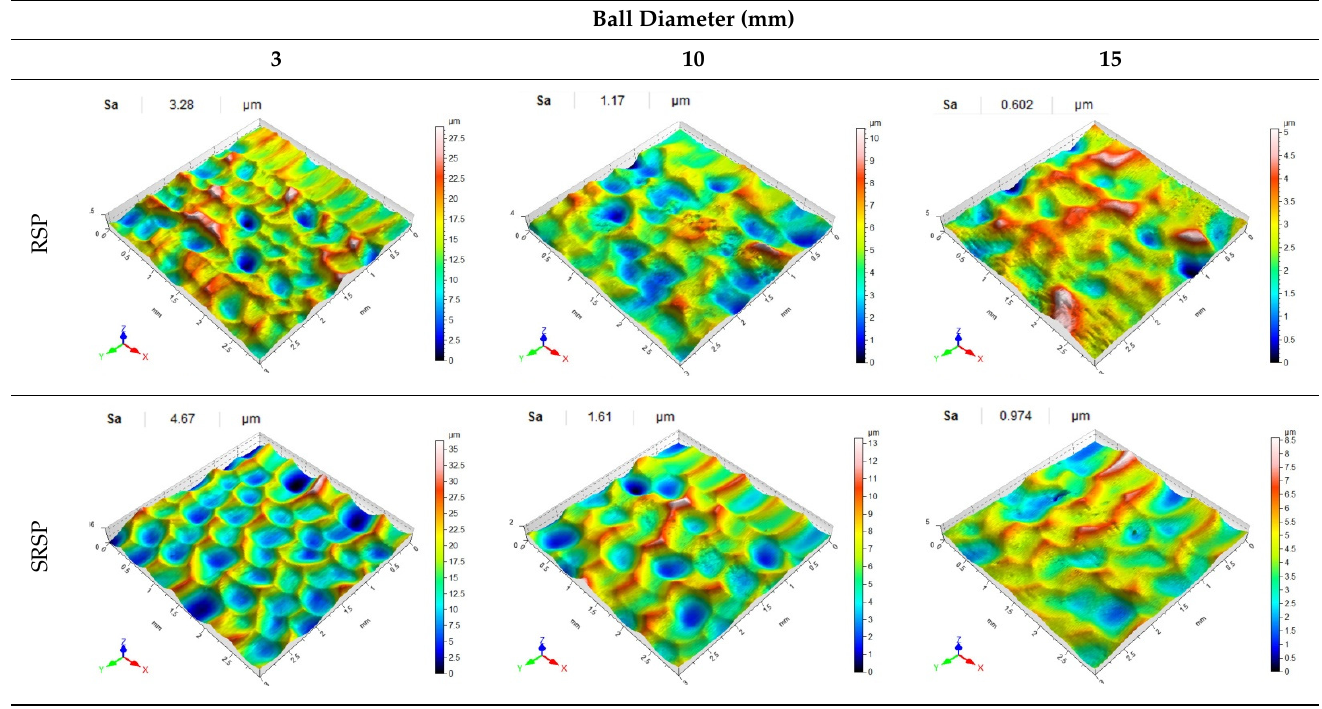
Table 7. Effect of the shot-peening element diameter on the Sa roughness parameter and surface topography (impact energy E = 100 mJ, distance between dimples x = 0.3 mm).